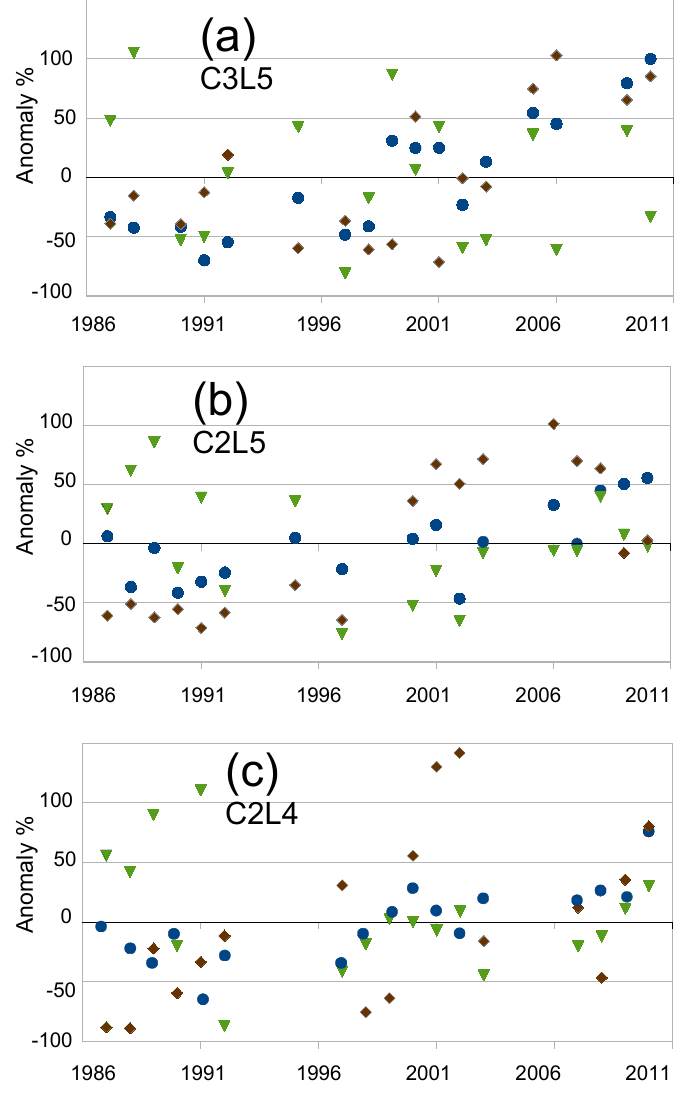
Figure 7. Anomalies of CSE biomass at monitoring sites C3L5 ( a ); C2L5 ( b ) and C2L4 ( c ) and integrated GEOV1 FAPAR from 1987 to 2010. Note that biomass data is not